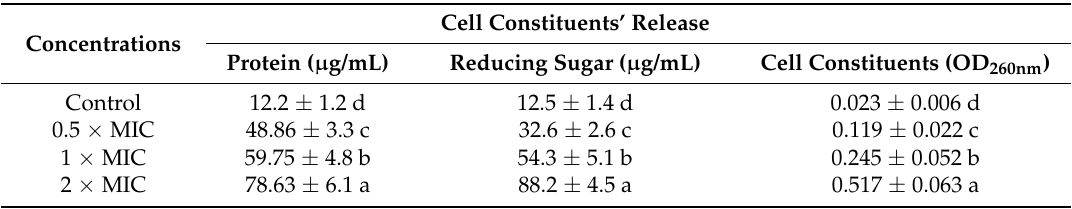
Table 2. Effects of the essential oil on cell constituents' release of S.